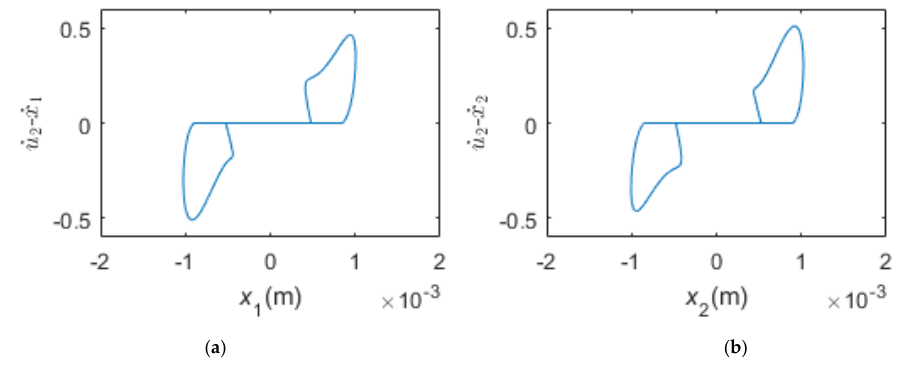
Figure 15. The relative velocity of the contact points versus displacements of the dampers, ( a ) left damper; ( b ) right damper.